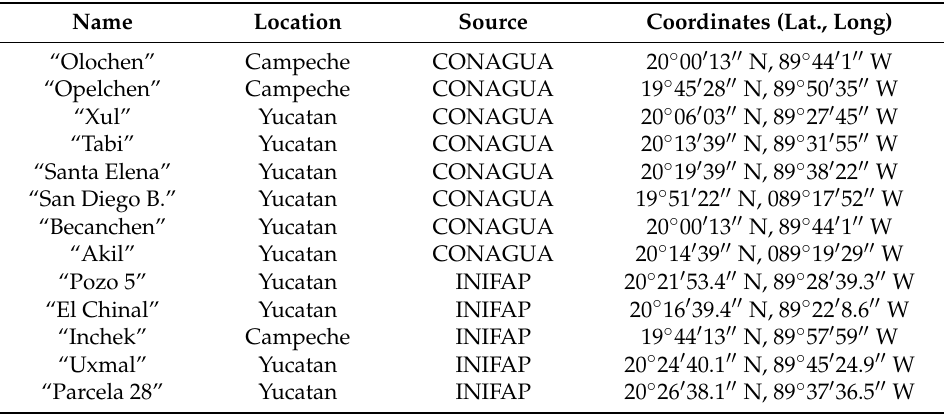
Table 1. Meteorological stations used in this